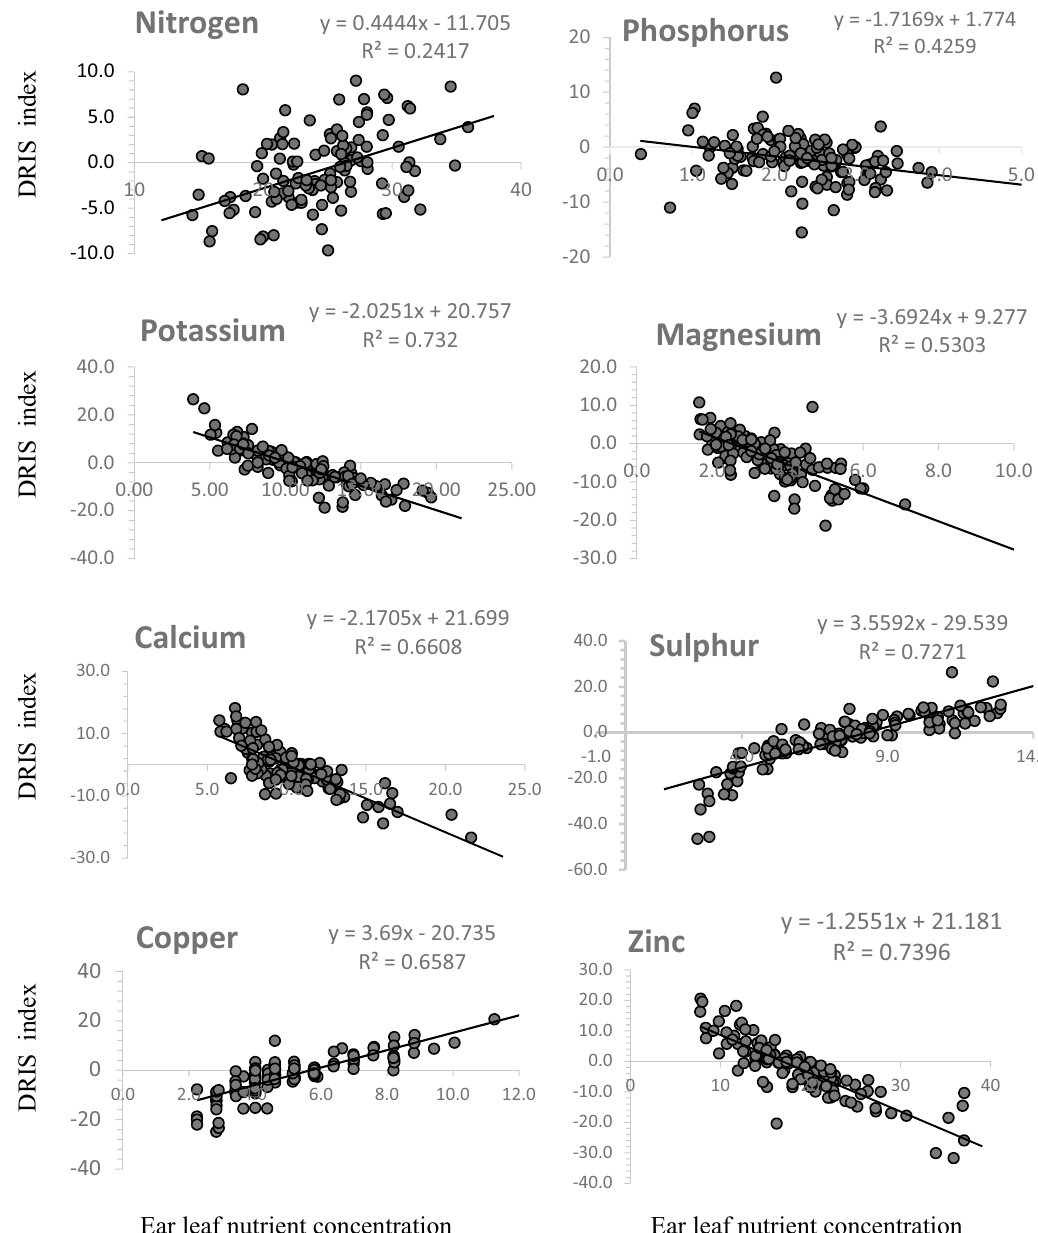
Figure 1. Relationship between ear leaf nutrient concentrations and corresponding nutrient DRIS